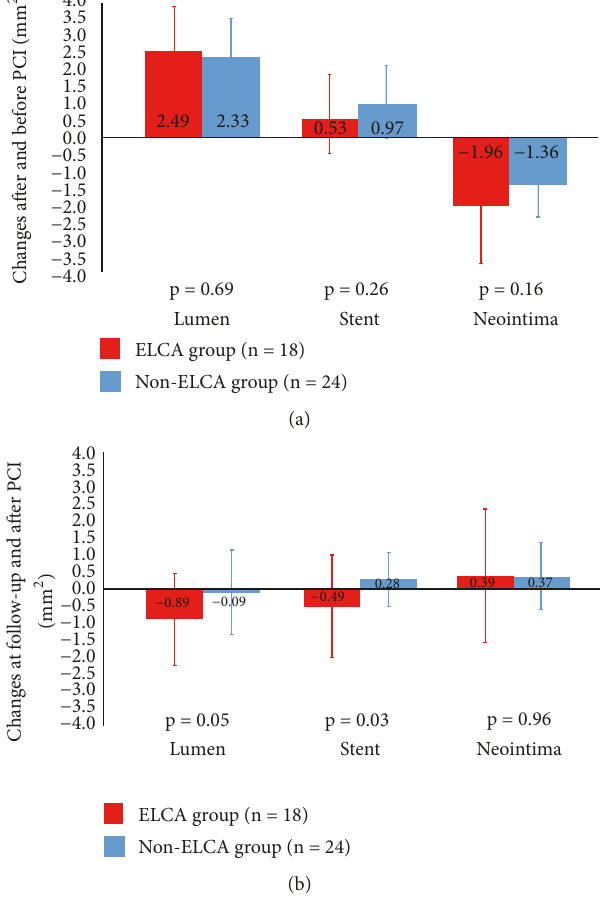
Figure 3: Comparison of MLCSA, MSCSA, and neointimal CSA between the ELCA group and the non-ELCA group. The changes in the MLCSA and MSCSA before, after PCI, and at 6 months of follow-up between the ELCA and the non-ELCA group are shown (a, b). (a) The changes after and before PCI in the MLCSA, MSCSA, and neointimal CSA were similar in both groups. (b) A decreased tendency in the MLCSA (-0.89 ± 1.36 mm 2 vs. -0.09 ± 1.25 mm 2 , p = 0.05)andasignificantdecreaseintheMSCSAwasobservedbetween 6-month follow-up and after PCI in the ELCA group (-0.49 ± 1.48 mm 2 vs. 0.28 ± 0.78 mm 2 , p = 0.03). The changes in the neointimal CSA showed no significant difference (0.39 ± 1.94 mm 2 vs. 0.37 ± 0.98 mm 2 , p = 0.96). MLCSA, minimum lumencross-sectionalarea; MSCSA, minimum stent cross-sectional area; ELCA, excimer laser coronary atherectomy; PCI, percutaneous coronary